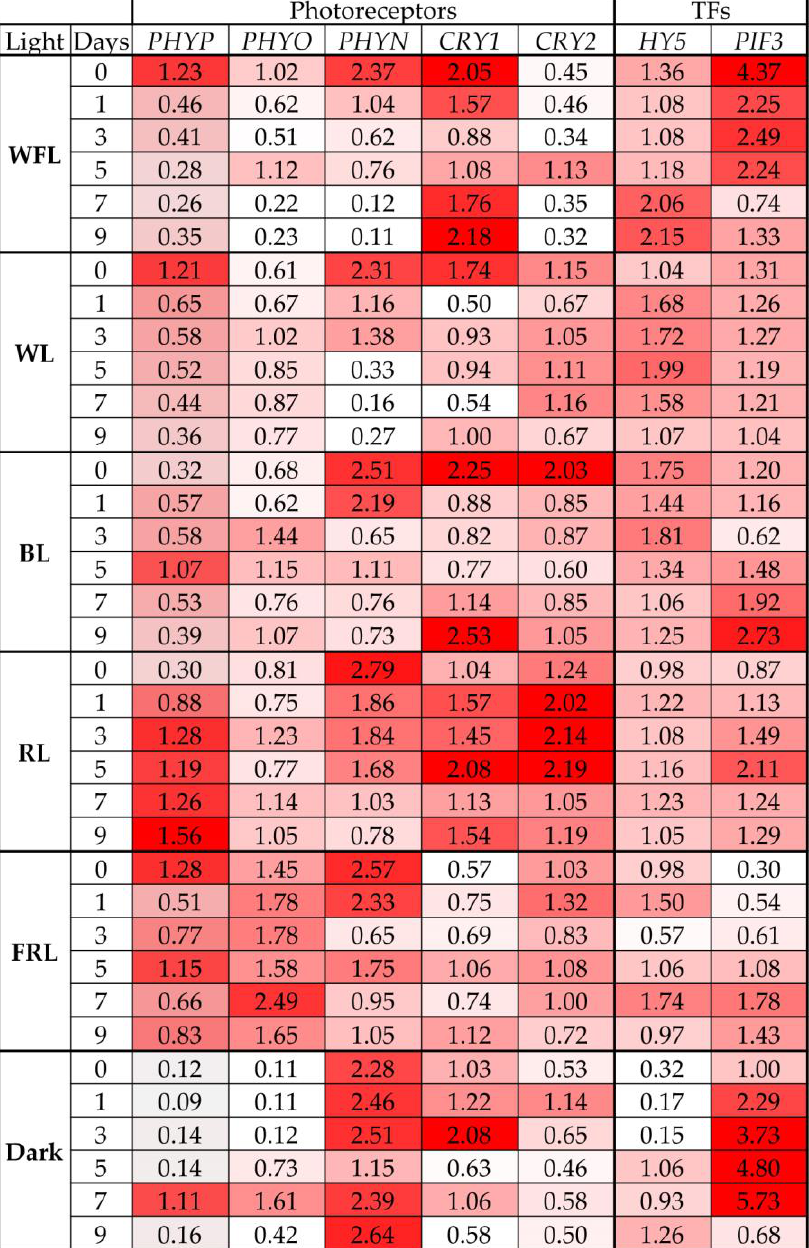
Figure 4. Transcript levels of main photoreceptors ( PHYP, PHYO, PHYN, CRY1, CRY2 ) and transcription factors involved in light signaling ( HY5, PIF3 ) in Scots pine plantlets under different light quality and dark conditions on days 0, 1, 3, 5, 7 and 9 of the experiment. The color scale rules: increase in expression by at least two times (dark red light) relative to the average value of the expression of the specified gene in column.